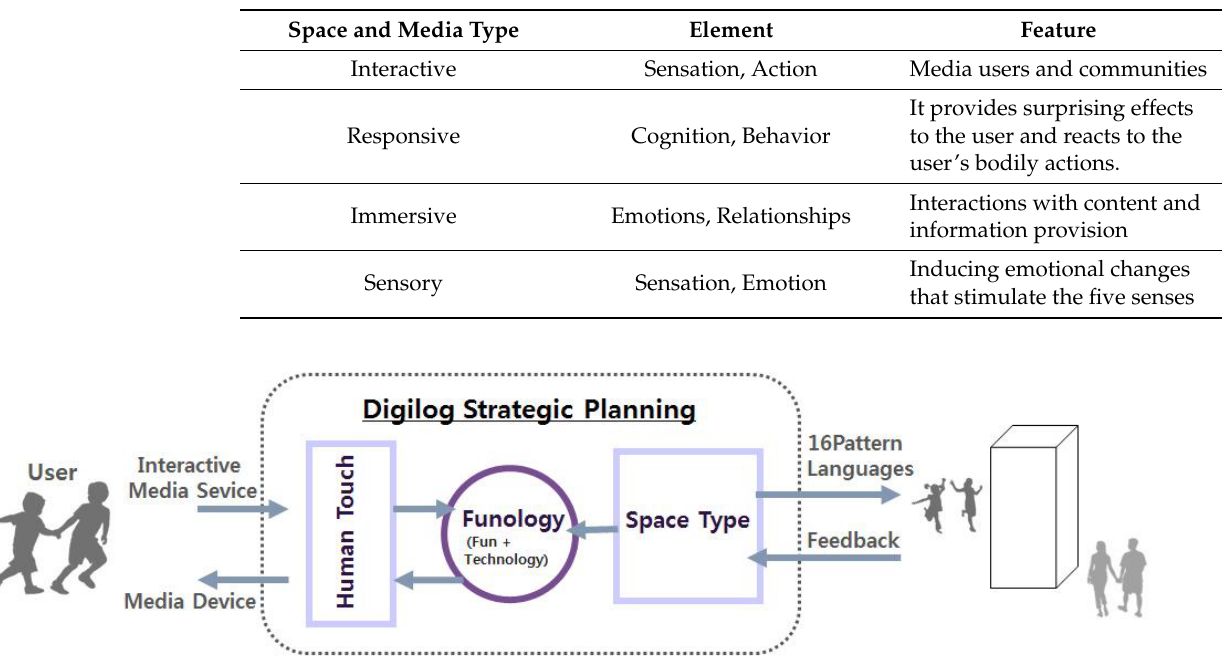
Table 3. Media experience type classification [2,12,17]—the communication infrastructure element for user behavioral characteristics: (1)–(3).